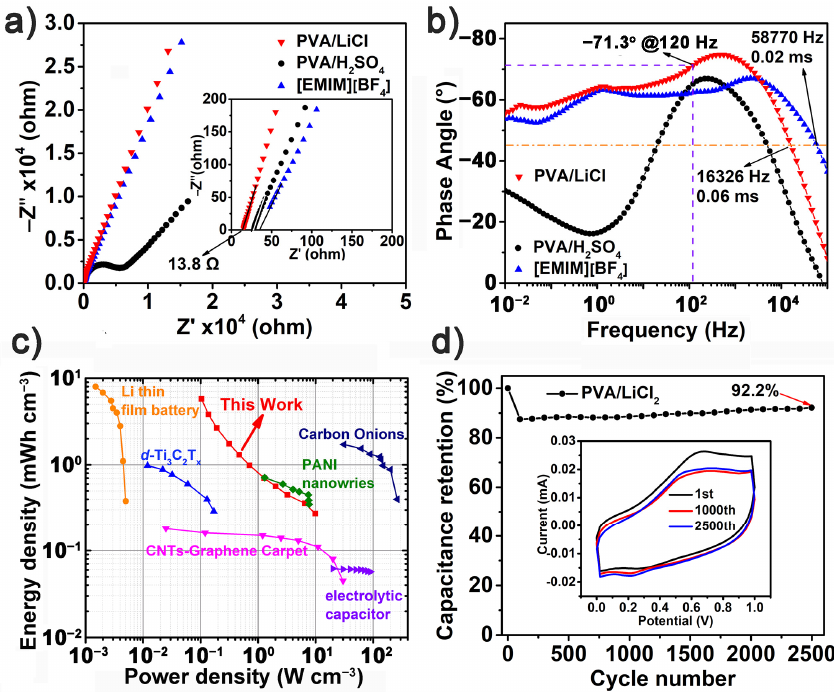
Figure 6. ( a ) Nyquist plots; ( b ) impedance phase angles on the frequency of TpPB-Fe-MSCs with PVA/LiCl (red), PVA/H 2 SO 4 (black) and [EMIM][BF 4 ] (blue); ( c ) Ragone plots for TpPB-Fe-MSCs with PVA/LiCl (red), PVA/H 2 SO 4 (black) and [EMIM][BF 4 ] (blue), comparing with other reported MSCs; ( d ) Cycling stability of TpPB-Fe-MSC with PVA/LiCl electrolyte (scan rate: 500 mV s − 1 ), insert: the 1st, 1000th, 2500th CV curves of TpPB-Fe-MSC with PVA/LiCl electrolyte.